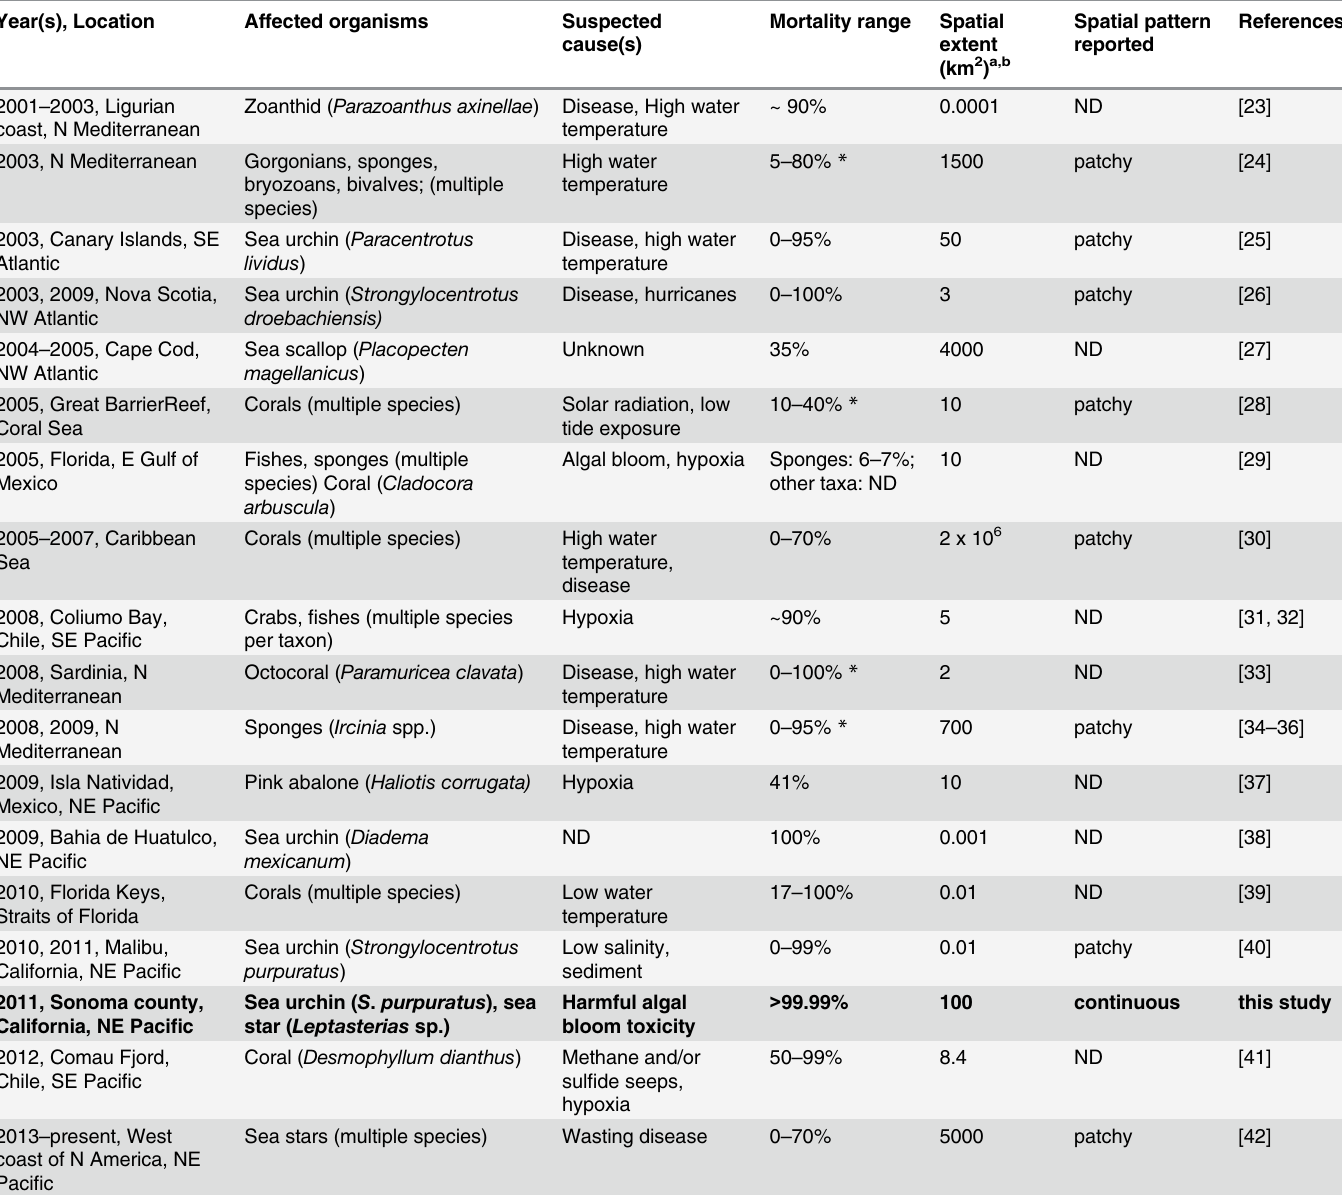
Table 1. Mass mortality events of benthic marine species occurring since